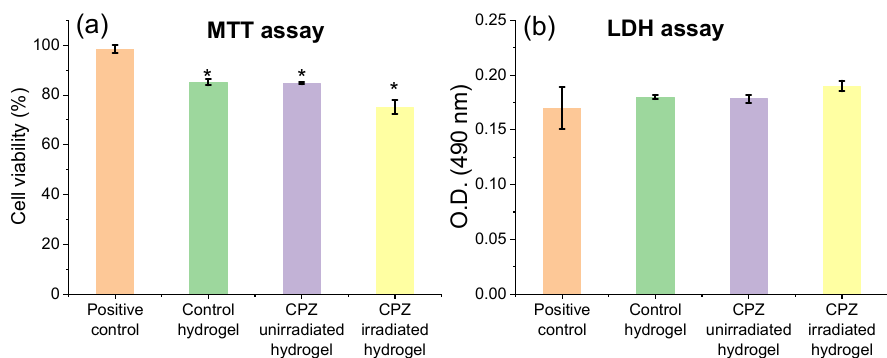
Figure 12. ( a ) In vitro L929 cell viability after 24 h incubation with the hydrogel loaded with 2 mg/mL unirradiated CPZ, and the hydrogel loaded with 2 mg/mL irradiated for 30 min CPZ; ( b ) LDH release after membrane damage of L929 cells incubated with samples for 24 h; the positive control represents L929 cell in standard culture conditions in the absence of hydrogels; data expressed as mean ± SD, n = 3, data points analyzed by t -test, levels of statistical significance between the analyzed groups of * p ≤ 0.05;.